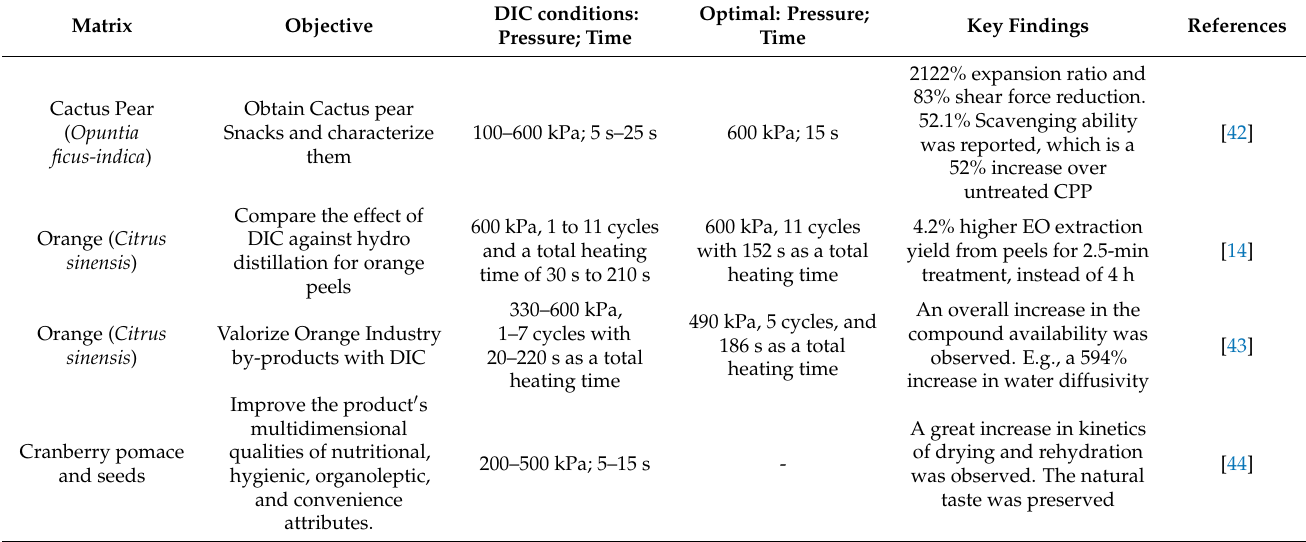
Table 2. DIC conditions to treat food byproducts and some key